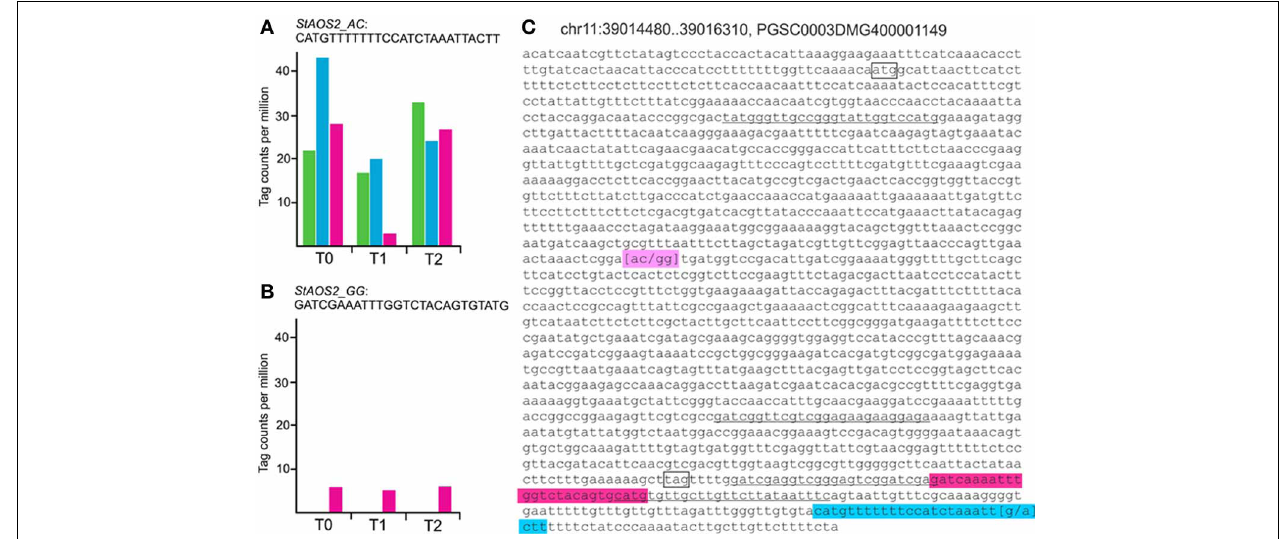
FIGURE 4 | Tags derived from the StAOS2 locus. Normalized tag counts (tpm) of two tags corresponding to haplotypes StAOS 2_ A 691 C 692 (A) and StAOS 2_ G 691 G 692 (B) in genotype pools A1 (green), A2 (blue) and B2 (pink) before (T0), one (T1) and 2 days (T2) after infection with a compatible isolate of P. infestans . For detailed tag counts see Supplementary Table S6 . (C)